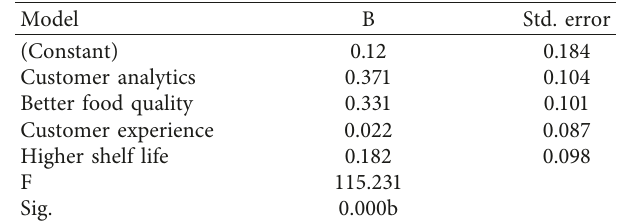
Table 1: Percentage analysis of demographic